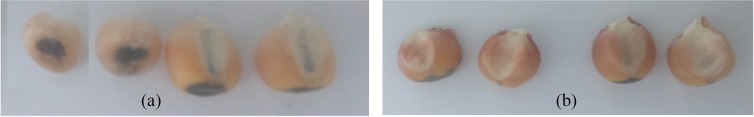
The photographs of the haploid and diploid of Zheng58 and Yu87-1.(a) Zheng58, the left 2 kernels are haploid, and the right 2 kernels are diploid; (b) Yu87-1, left 2 kernels are haploid and the right 2 kernels are diploid.